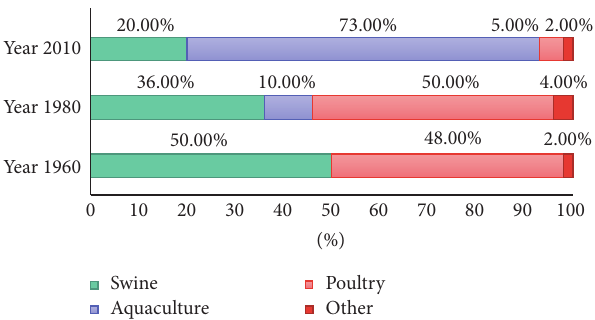
Figure 3: During processing, the fillets are considered usable and the remainder is waste.